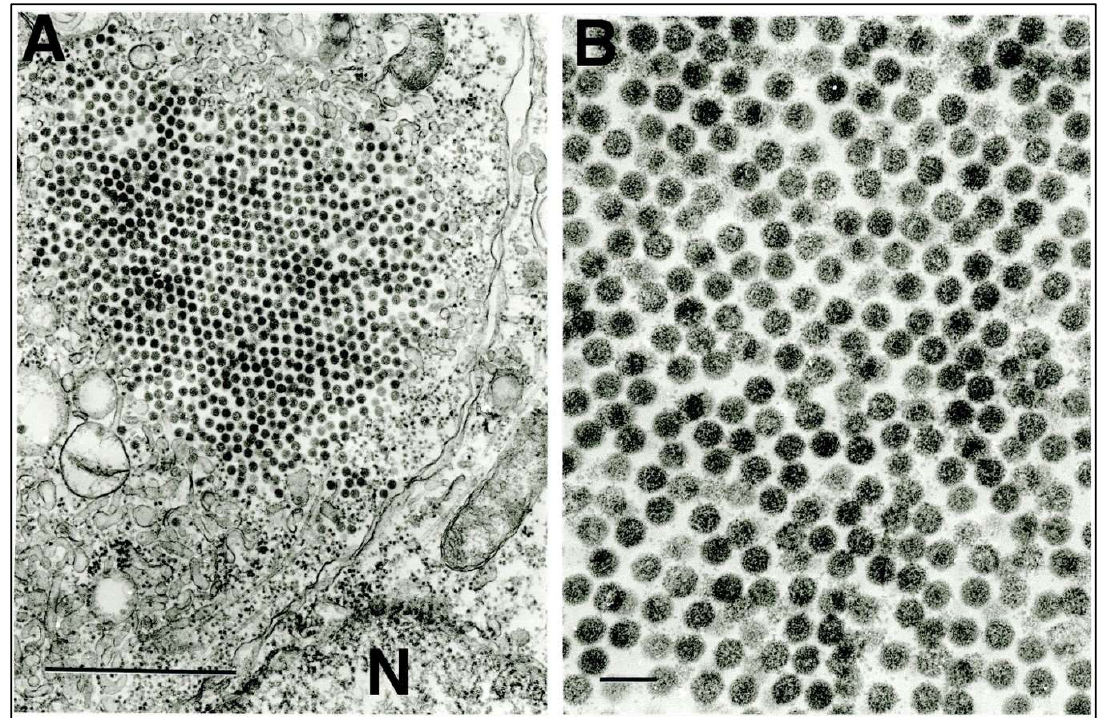
Figure 2. Ultrastructure of entomobirnavirus GMC-202 in C6/36 mosquito cells. (A) Paracrystalline agglomeration of virus particles in the cell cytosol. N = nucleus of adjacent cell. Bar = 1 μ. (B) Higher- power image of the agglomeration showing the details of virion ultrastructure. Bar = 100 nm.